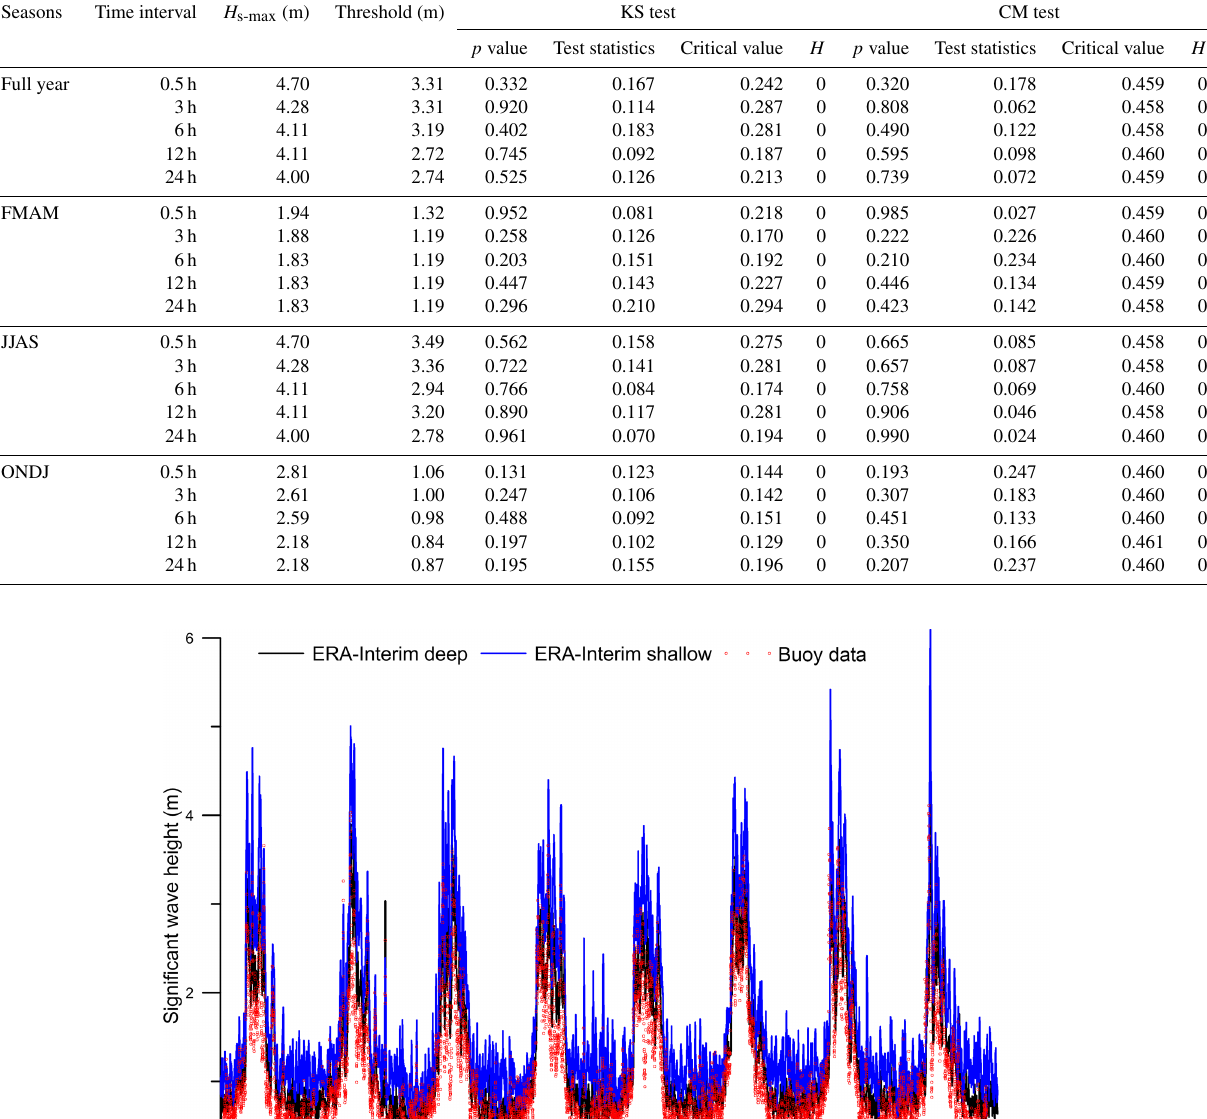
Table 2. Different goodness of fit tests used for selecting threshold values of POT analysis. H = 0 indicates that the test does not reject the hypothesis at the 5% significance level (i.e., p value > 0.05 or test statistics is less than critical value), and H = 1 indicates that the hypothesis is rejected. KS test represents the Kolmogorov–Smirnov test and CM test represents the Cramér–von Mises test. Seasons